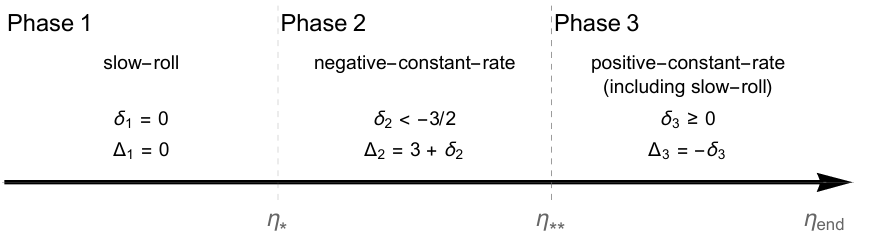
Figure 1 . A schematic description of the single-field inflation scenario considered in section 2 and 3, where δ i is the i -th phase rate-of-rolling of inflaton and ∆ i is the scaling dimensionality (conformal weight) of the late-time curvature perturbation R in each